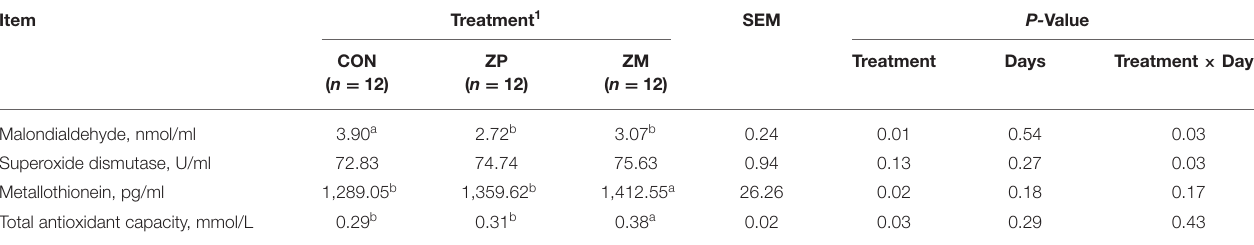
TABLE 4 | Effects of organic zinc sources on serum antioxidant status of dairy calves during the first month of life (Experiment 2). Item